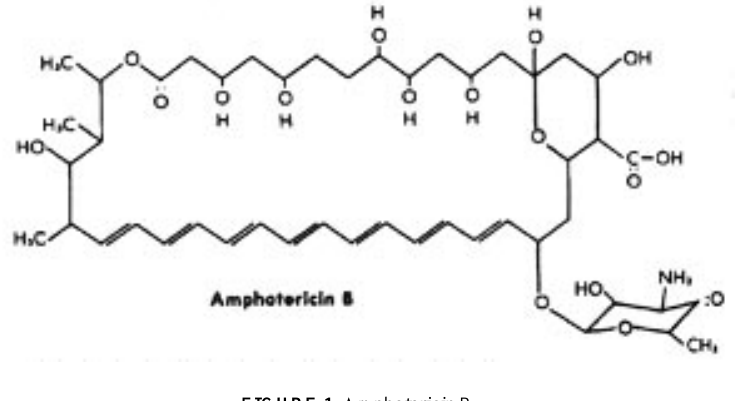
FIGURE 1. Amphotericin